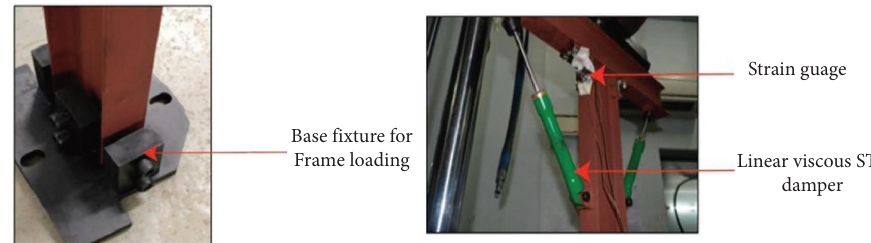
Figure 2: Photographic view of the base fxture and strain gauge over semi-rigid